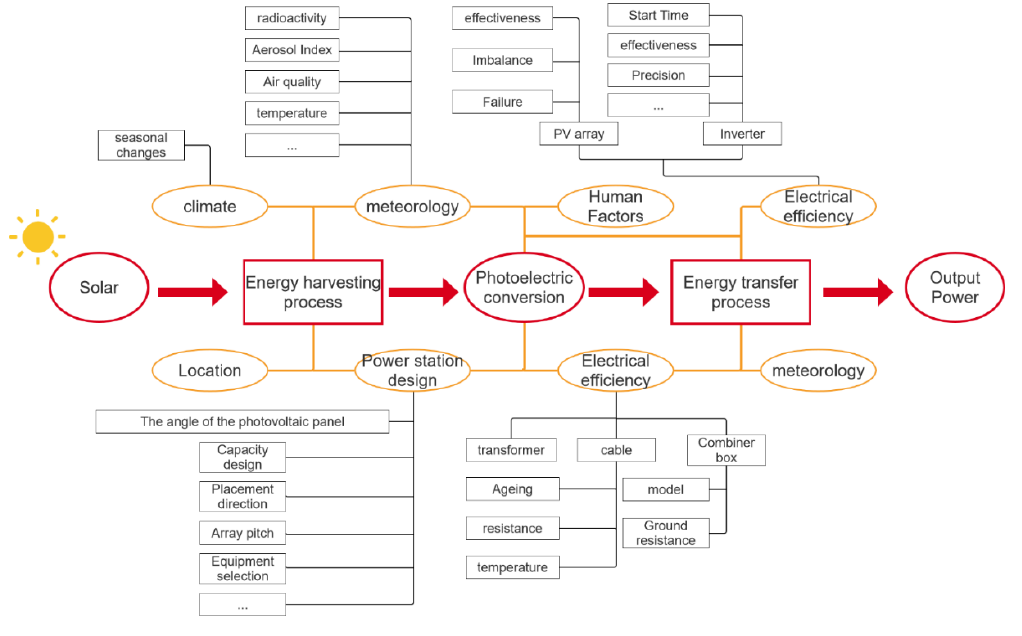
Figure 1. Influencing factors of PV generation.